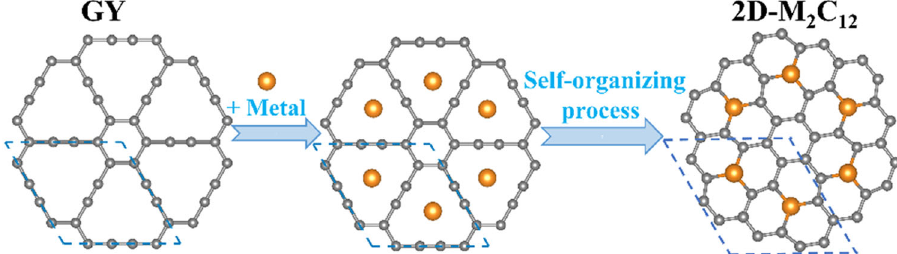
Fig. 1 The possible mechanism for the synthesis of 2D-M 2 C 12 from GY. The triangular hollow sites in GY are good-trapping sites for the metal atoms. Upon adsorption, the strong metal-carbon interactions induce lattice reconstruction in a self-organizing process forming 2D-M 2 C 12 . Unit cells are enclosed in cyan dashed lines.